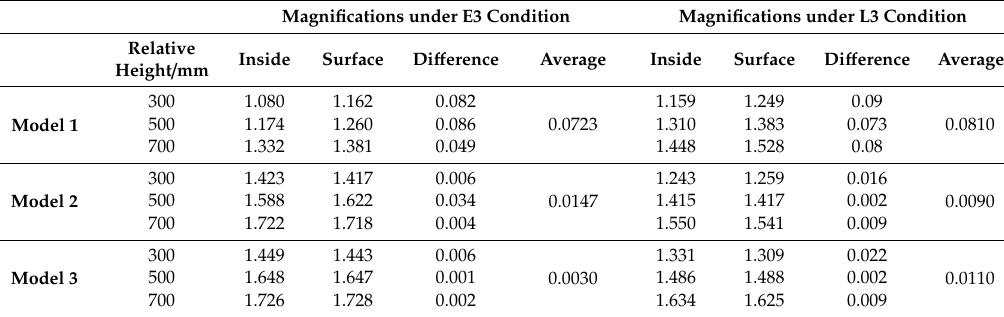
Table 3. Comparison of HAM between slope surface and interior of